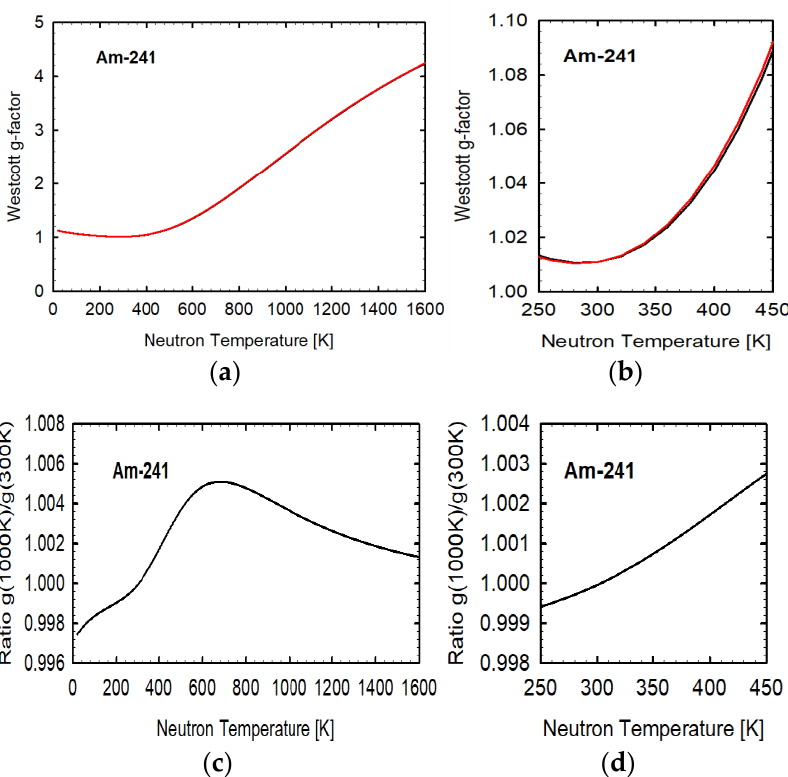
Figure 4. ( a ) Westcott g-factor for 241 Am as a function of neutron temperature 𝑇 𝑛 , for two sample temperatures, 𝑇 𝑠 = 300 K (black) and 1000 K (red); ( b ) Expanded figure of (a); ( c ) Ratio of Westcott g-factor for 𝑇 𝑠 = 1000 K to that for 300 K; ( d ) Expanded figure of (c).